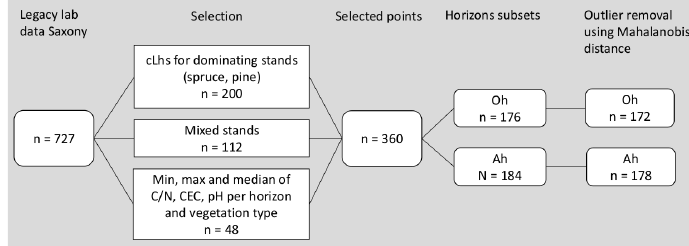
Figure 3. Graphical illustration of the sample selection